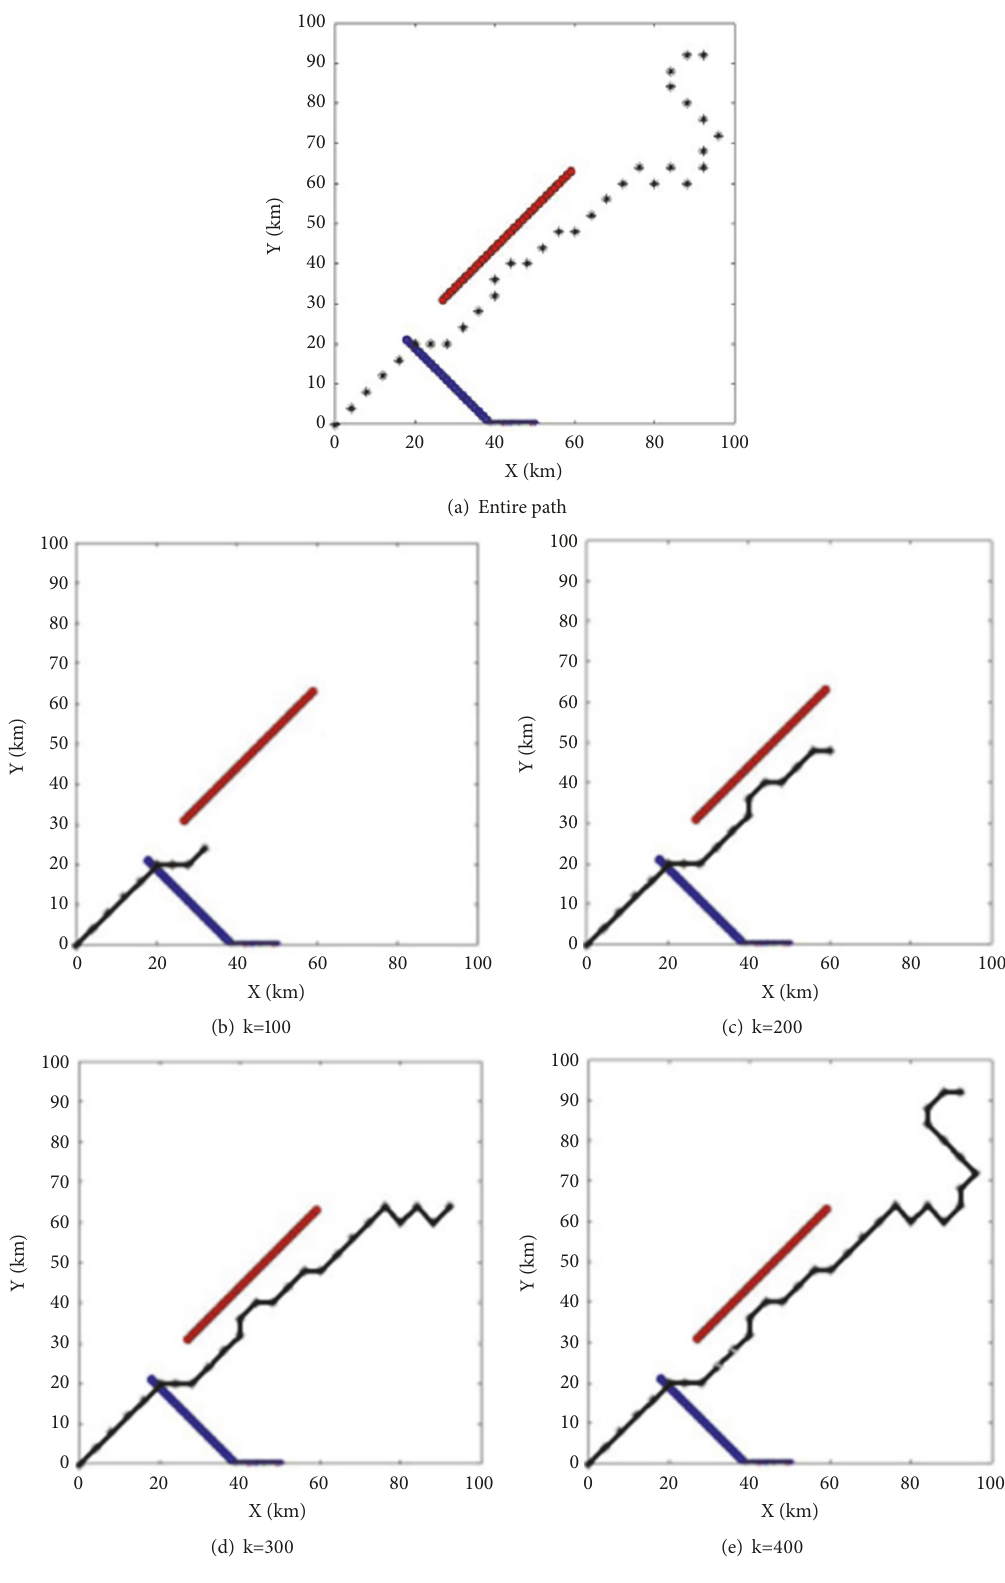
Figure 11: UAV path planning in one environment based on ACO algorithm. And there are only mobile threats where (a) is an entire path and (b) to (e) are paths with iterations = 100, 200, 300,